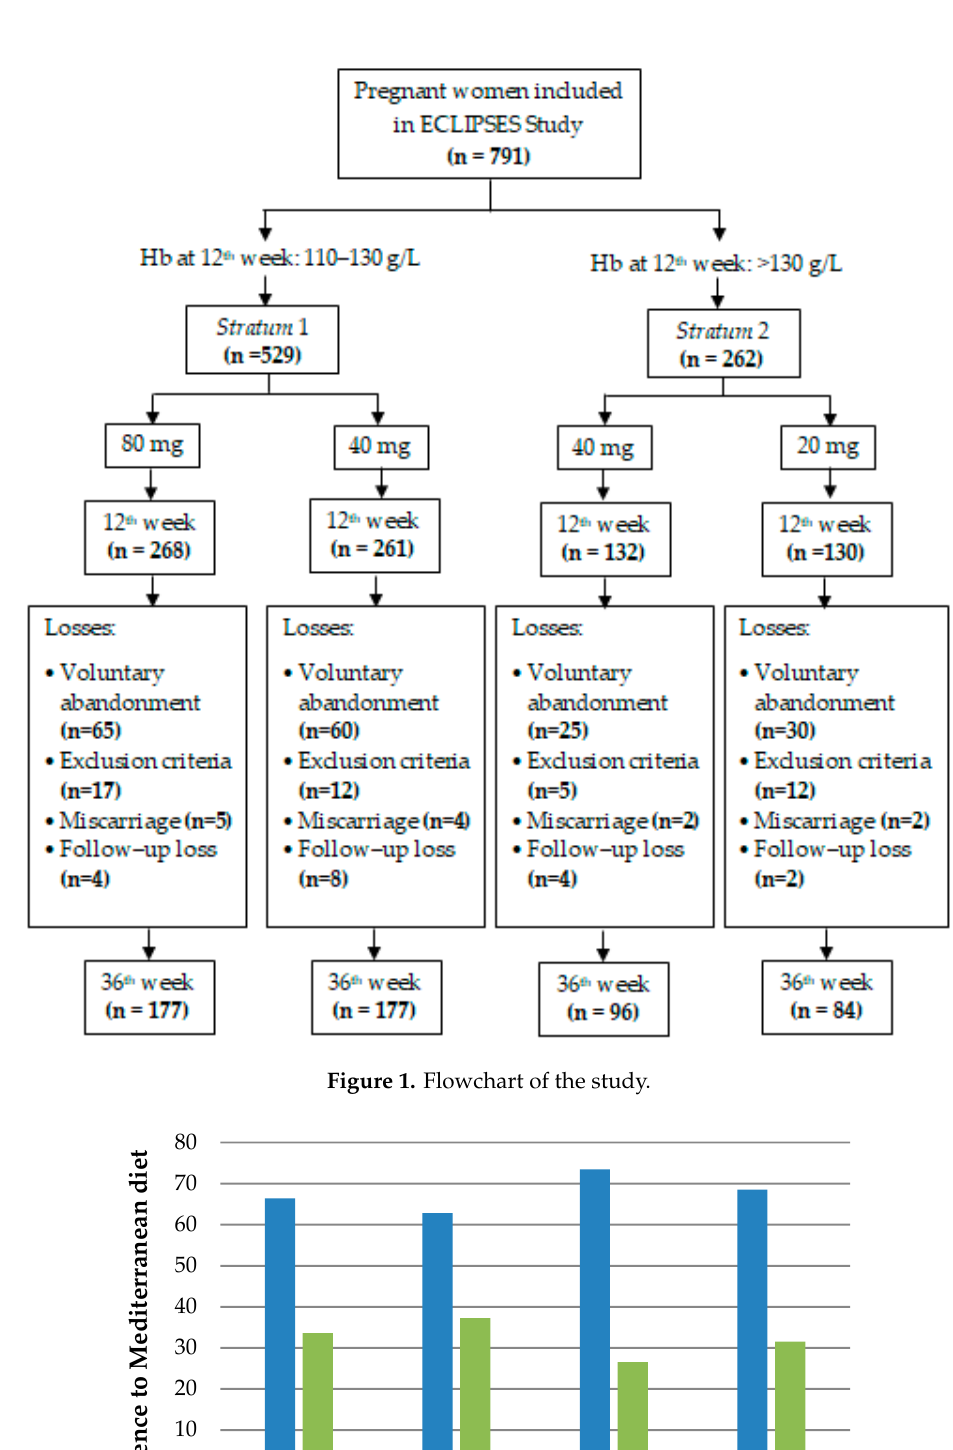
Figure 2. Adherence to the Mediterranean diet in the different groups of iron supplementation.